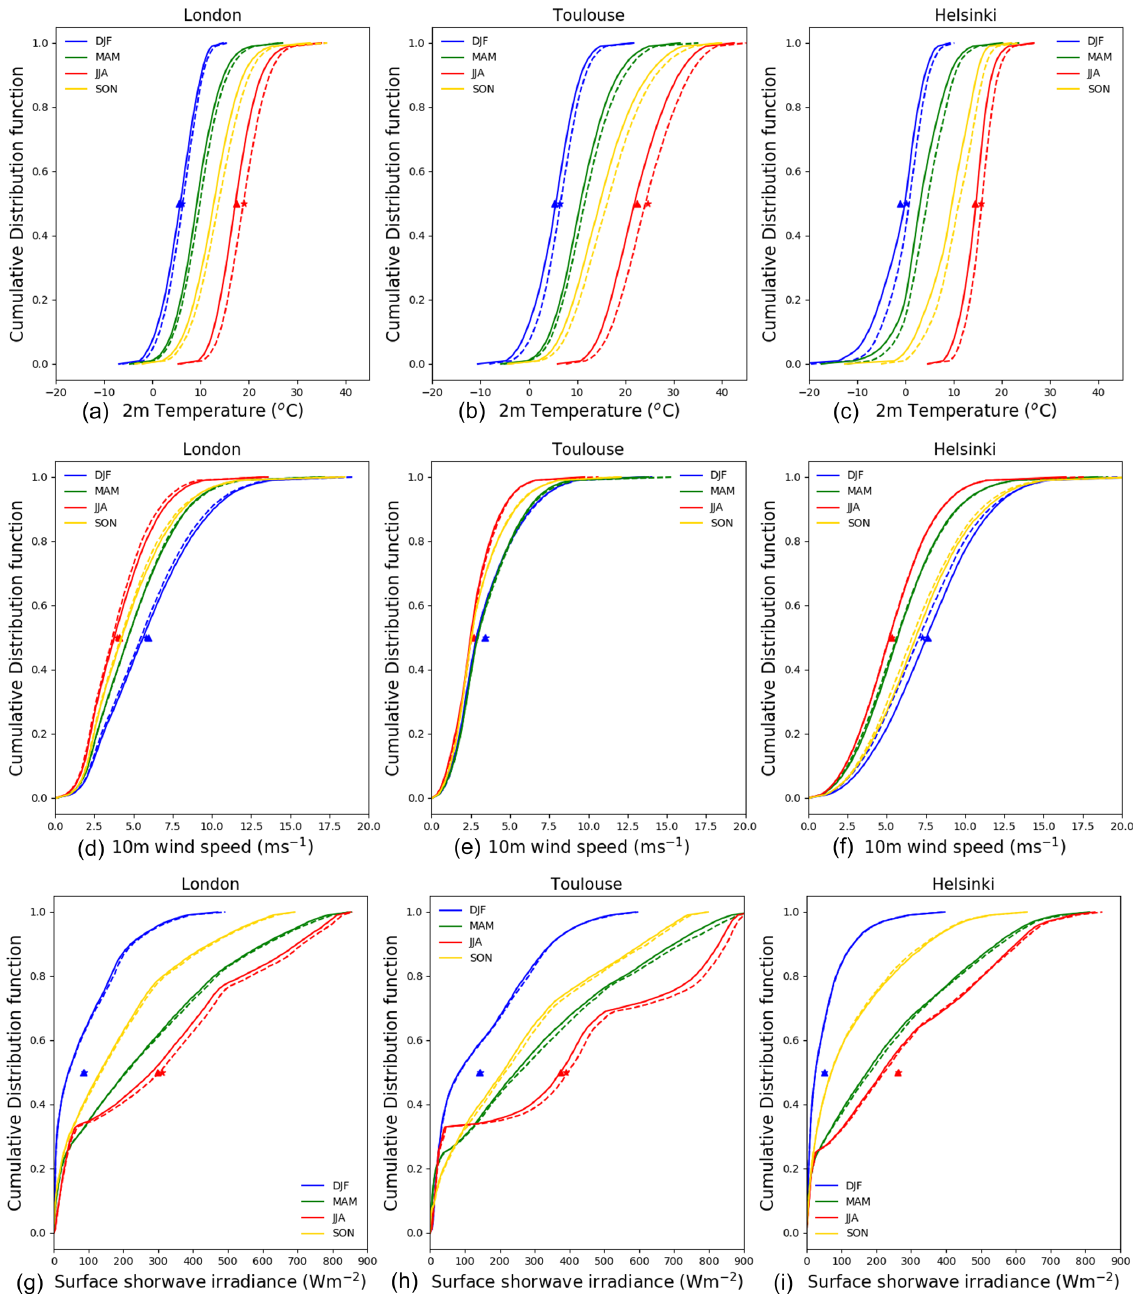
Figure 4. Seasonal percentile distributions of (a, b, c) 2m temperature, (d, e, f) 100m wind speed, and (g, h, i) surface short-wave radiation for the nearest grid point to three major European cities. Solid lines show ERA5; dashed lines show ERA5, including the impact of climate change from the ECEARTH-3P